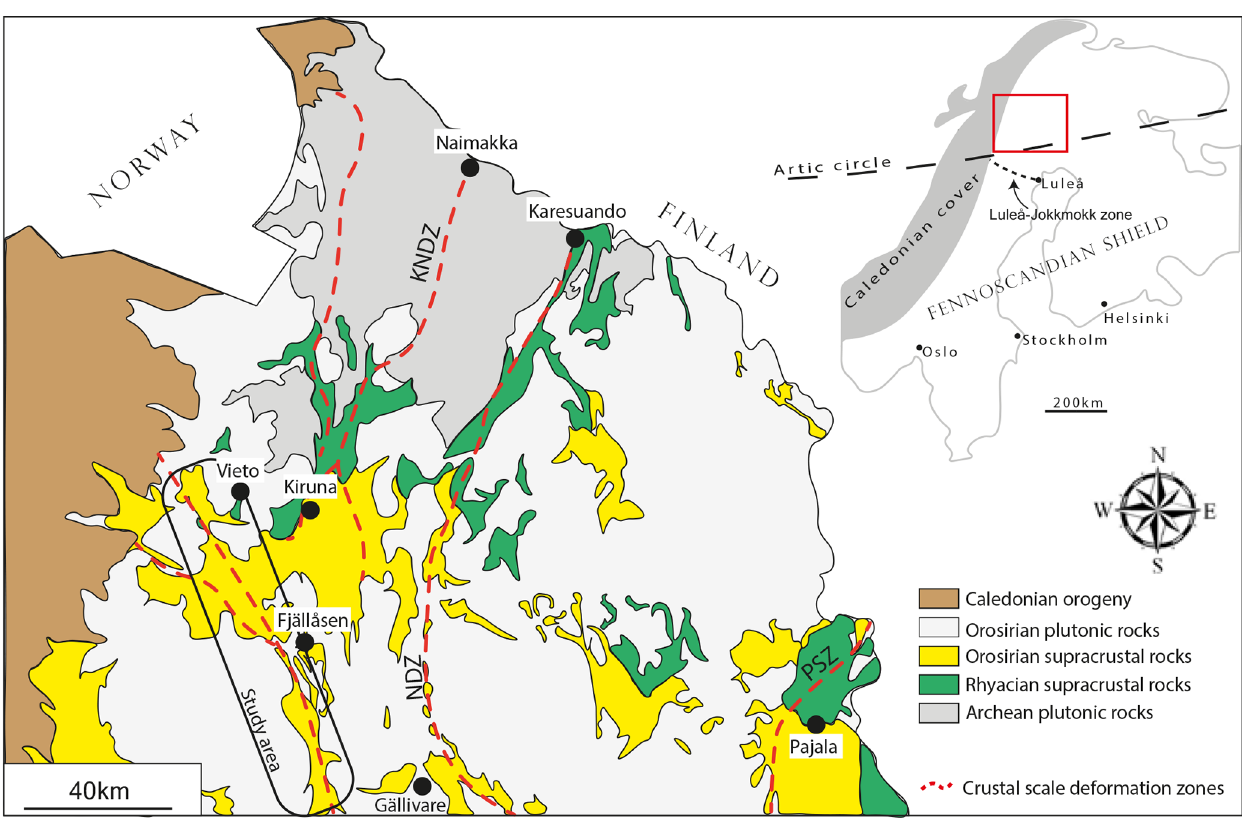
Figure 1. Generalized geology of northern Norrbotten highlighting Palaeoproterozoic supracrustal belts. Simplified and modified after Bergman et al.